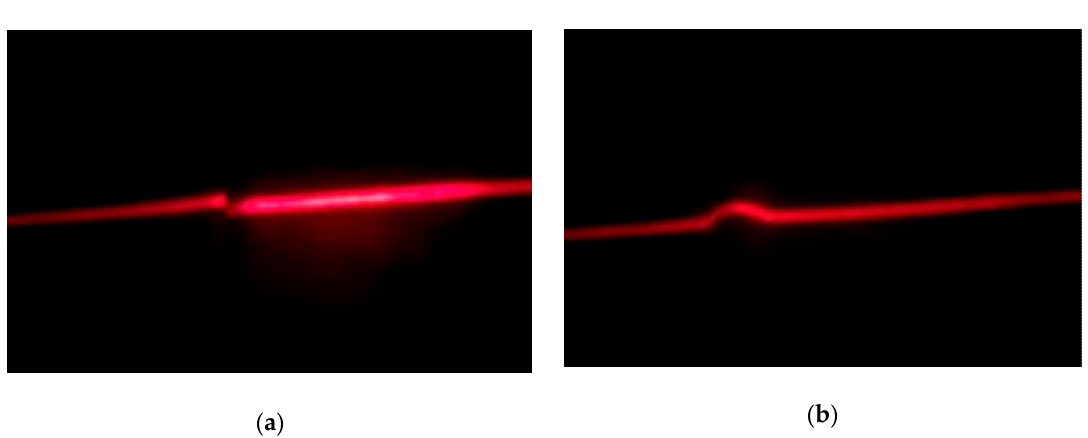
Figure 2. Images captured with the proposed system: ( a ) before welding operation; ( b ) after welding operation.